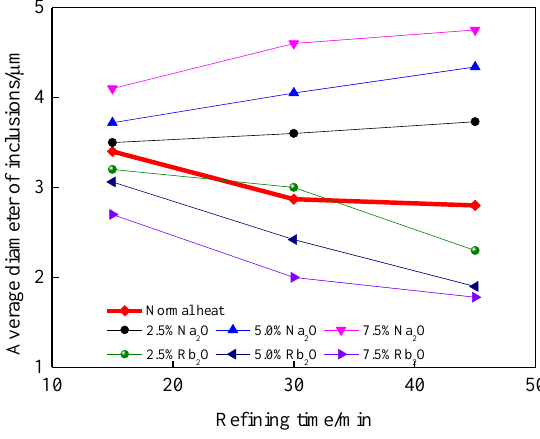
Figure 2. The average diameter of inclusion in experimental steel varies with refining time.